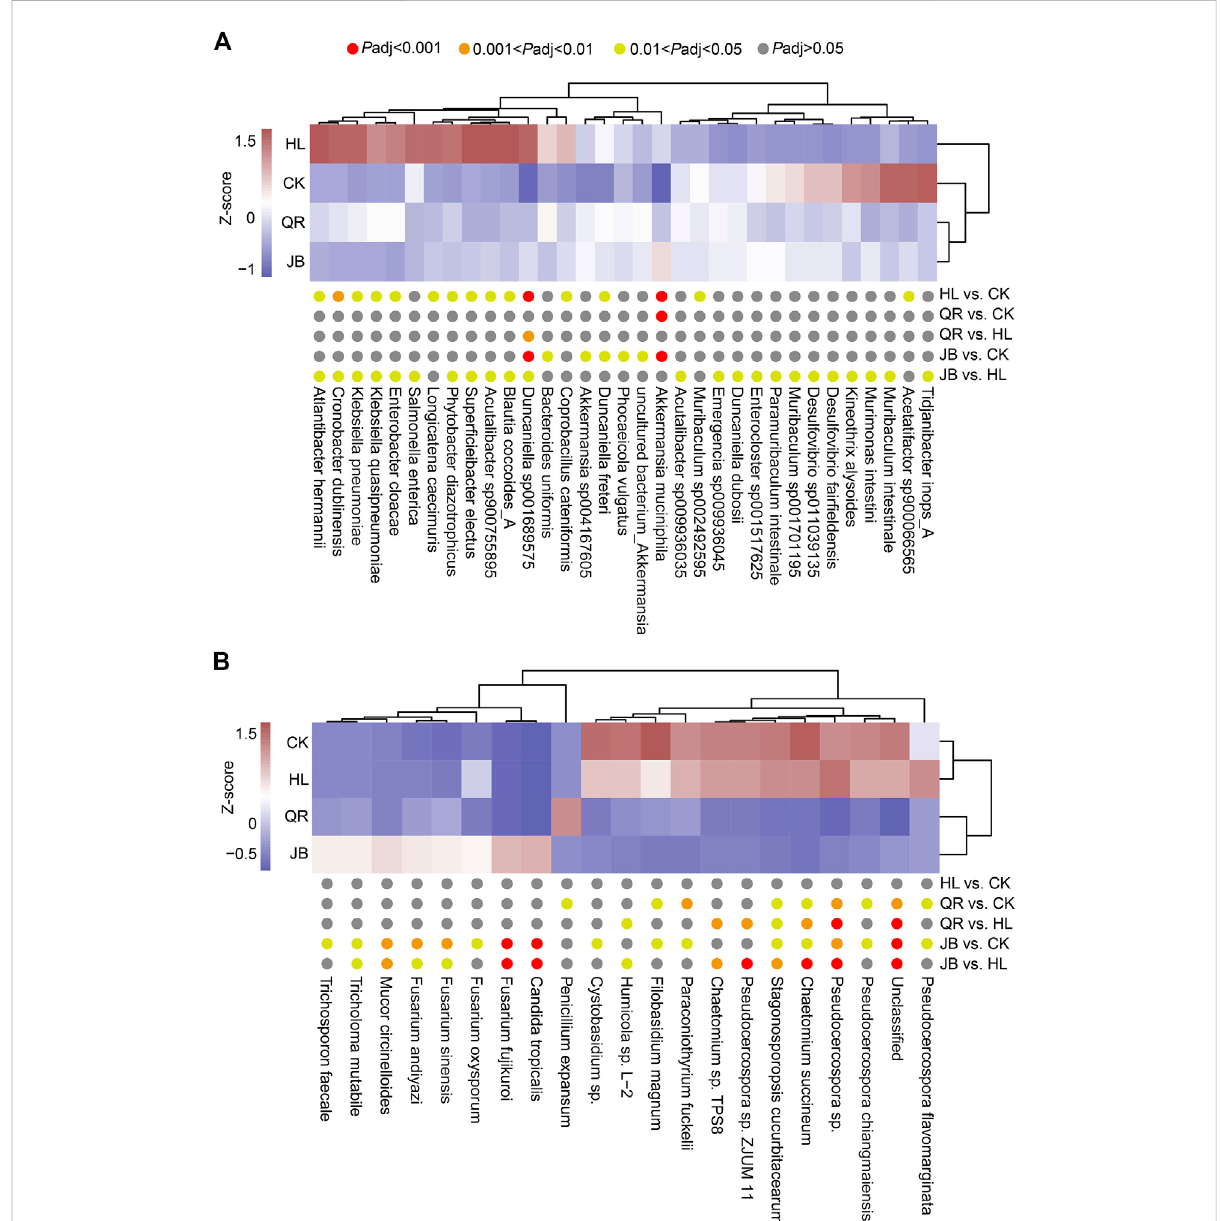
FIGURE 7 The differential species of gut bacteria and gut fungi. The heat map showed the differential species of (A) gut bacteria and (B) gut fungi which displayed by Z-score of relative